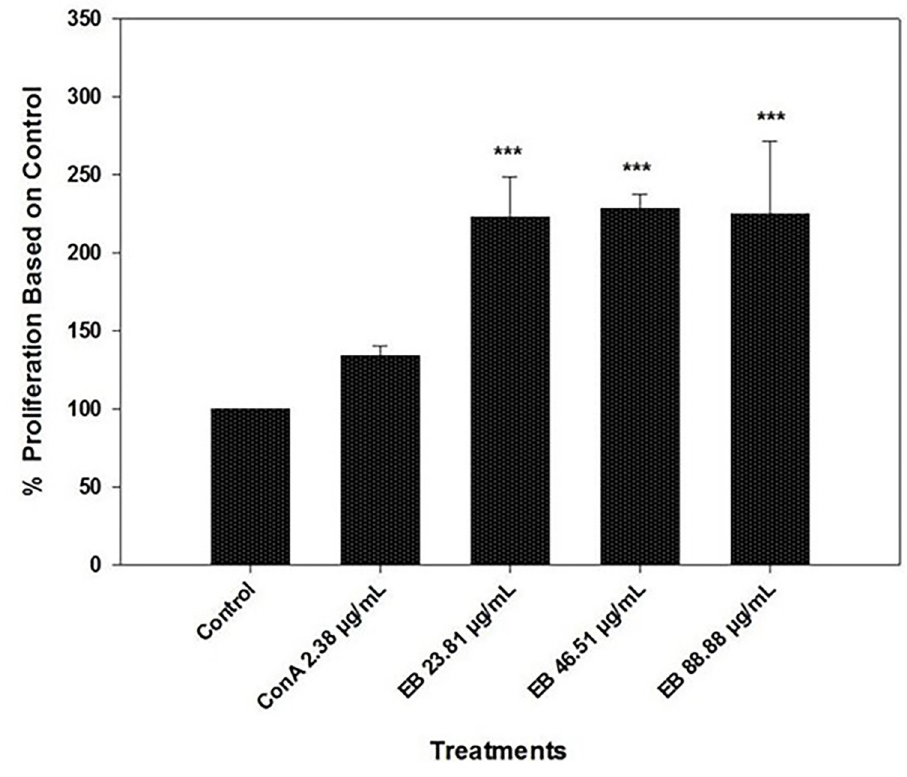
Fig 1. Proliferation of fish spleen T-cells in the prescence of Con A and various concentrations of elderberry extracts (23.81 μ g/mL, 46.51 μ g/mL, and 88.88 μ g/mL). All the elderberry extract concentrations were tested in the presence of Con A. Results are represented in means ± SEM. Asterisks represent a significant proliferation difference between treatment and control cell growth ( ��� = P < 0.001).